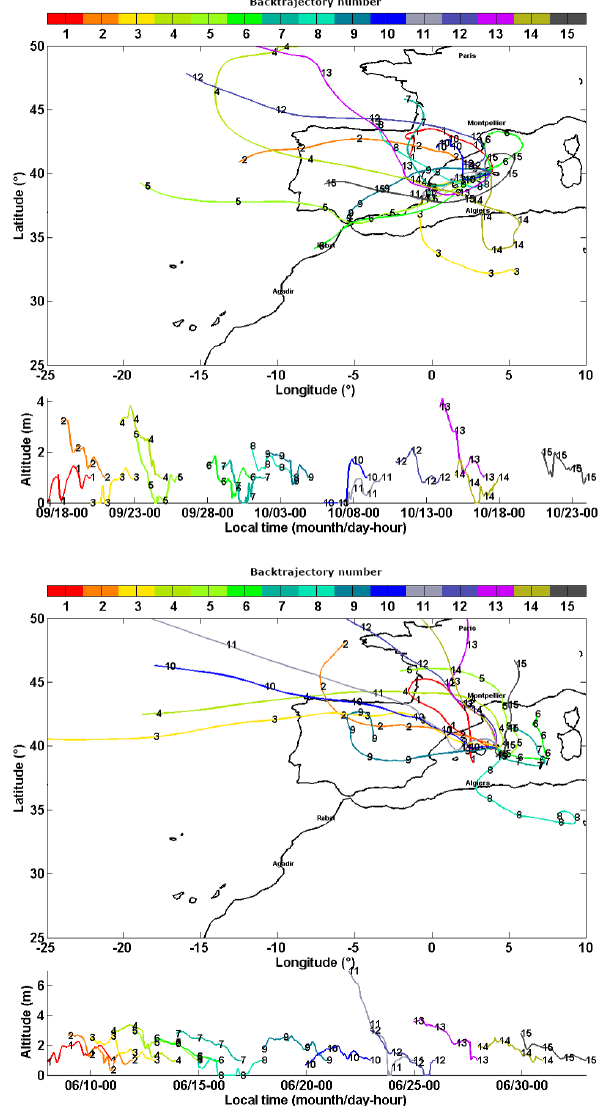
Figure 10. Back trajectories for each CN identified by the num- ber shown on the curves. They have been computed using the Hys- plit model (courtesy of NOAA Air Resources Laboratory; http: //www.arl.noaa.gov). The end locations of the air masses are for the sites of Ciutadella (top) and Mahon (bottom) for the HyMeX and ChArMEx time periods, respectively, at the altitudes of